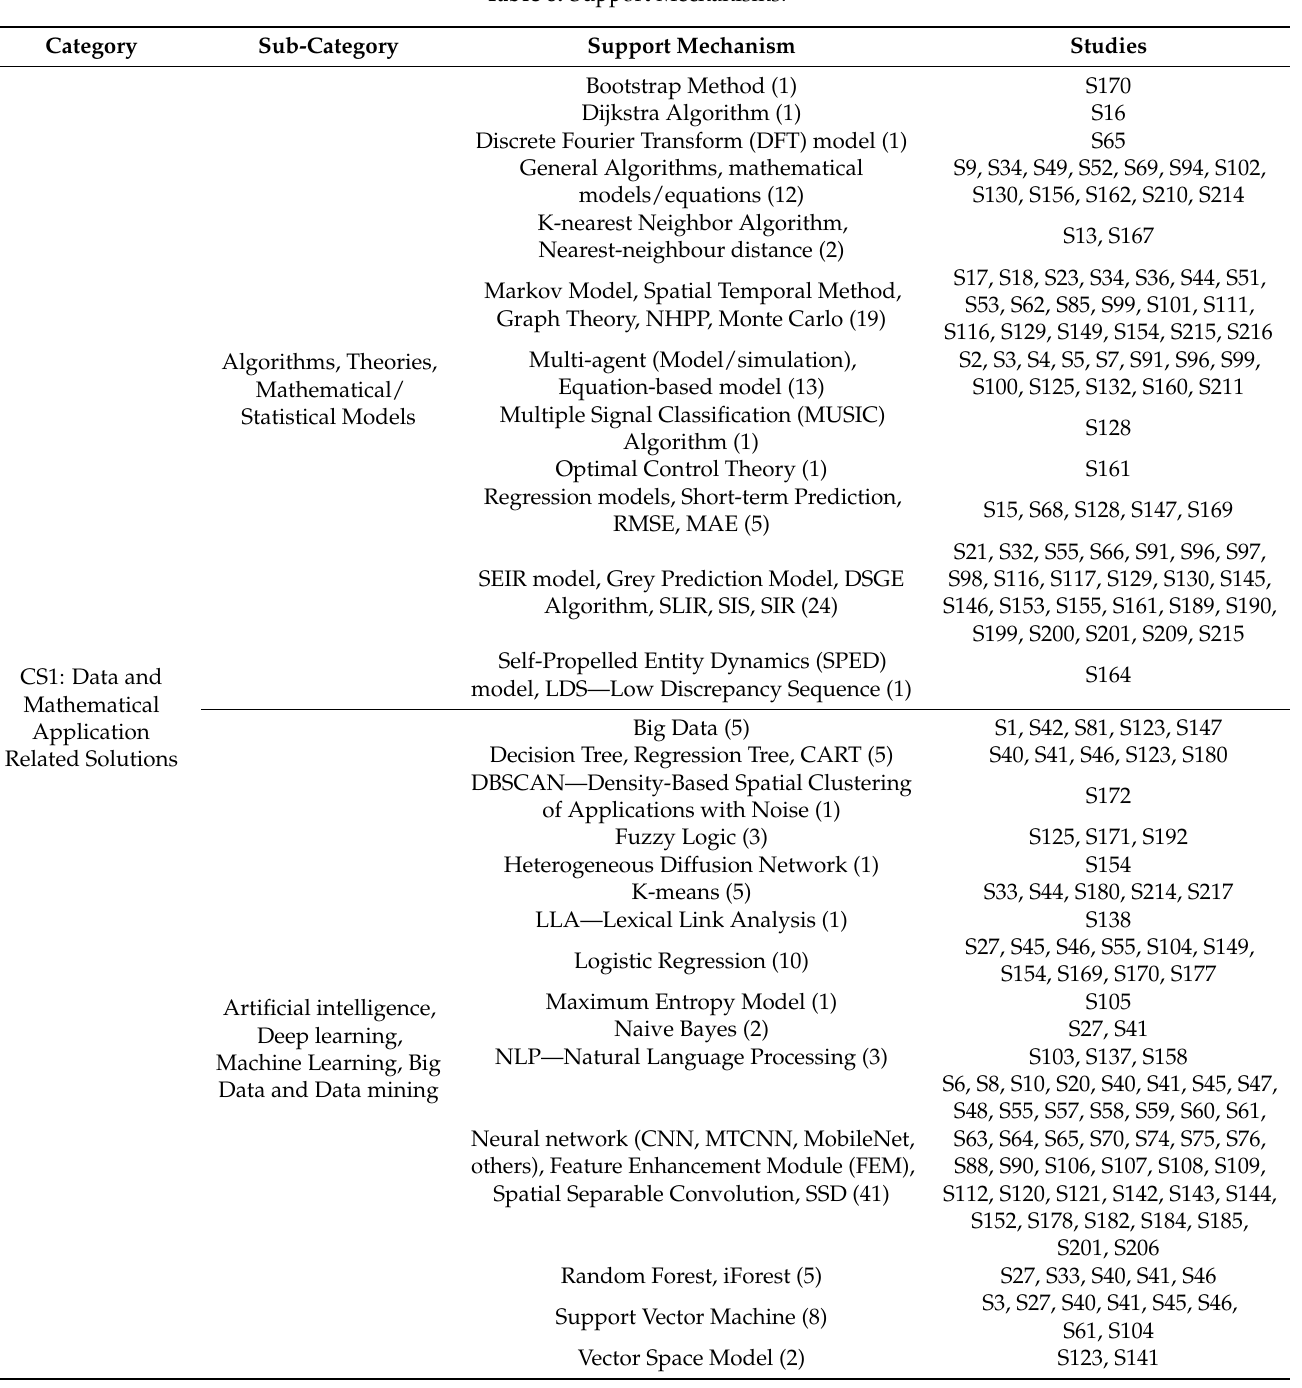
Table 8. Support